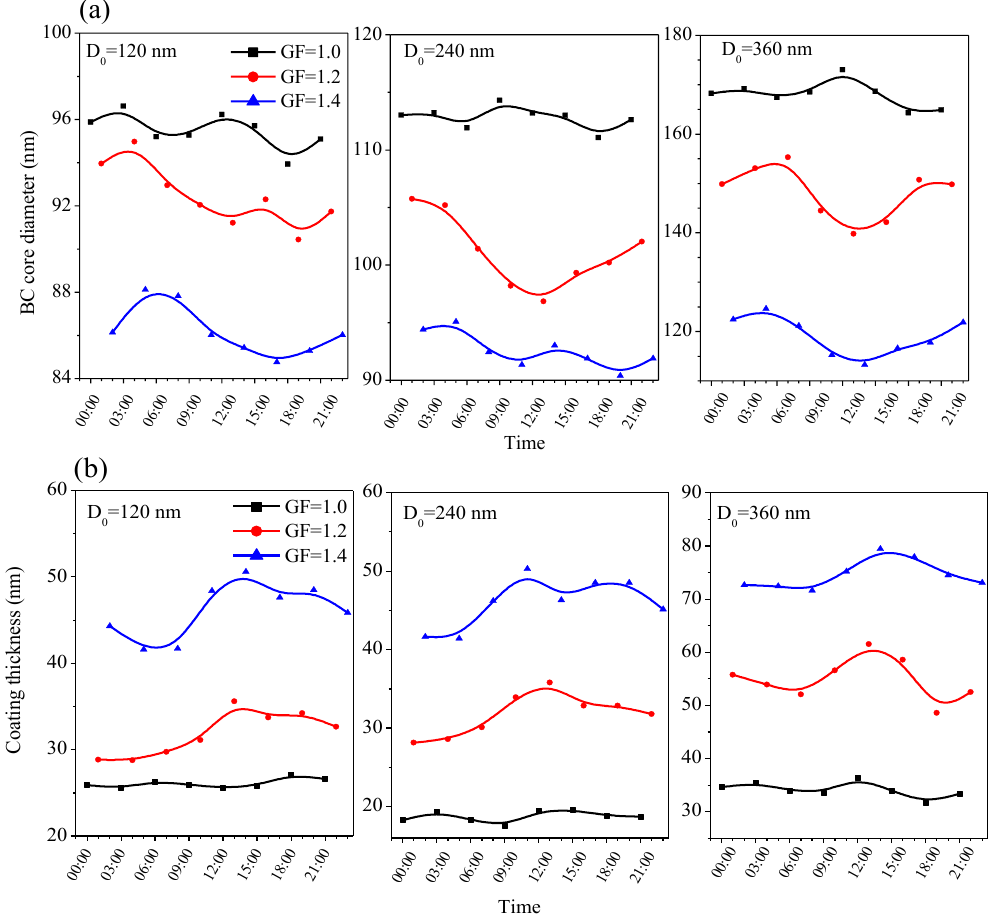
Figure 5. Diurnal variations in rBC (a) core size and (b) coating thickness at different